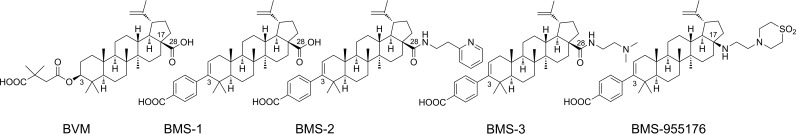
Structures of maturation inhibitors.